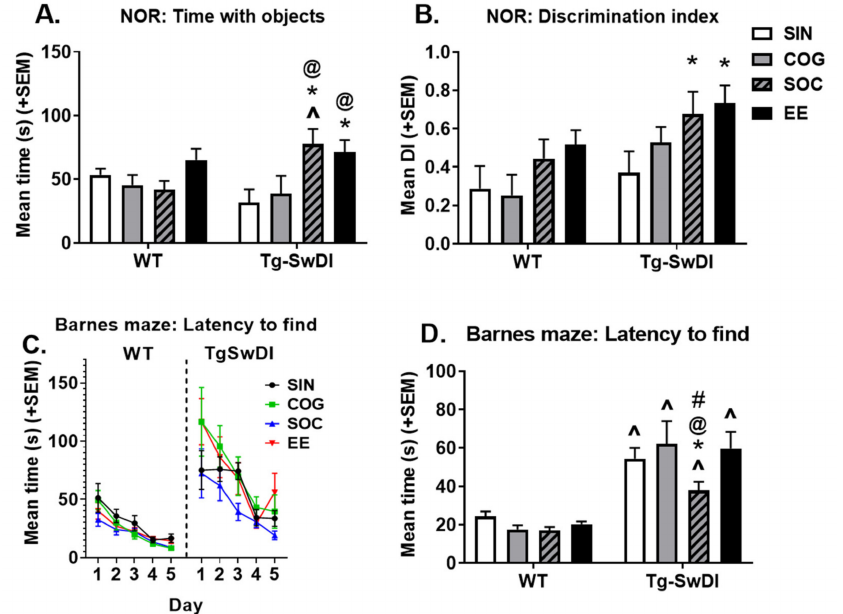
Figure 5. Cognitive testing. In Tg-SwDI mice, SOC and EE housing increased the amount of time spent with objects ( A ), and the discrimination index ( B ) in the novel object recognition (NOR) task. ( C ) Barnes maze performance, as measured by the latency to find the escape hole over time. ( D ) Barnes maze performance, as measured by the average latency to find the escape hole on days 2–5. Tg-SwDI mice took longer to find the escape hole compared to WT mice in all housing conditions. In Tg-SwDI mice, SOC housing was associated with improved performance (shorter latency to find the escape hole). * p < 0.05 vs. SIN of the same genotype, @ p < 0.05 vs. COG of the same genotype, % p < 0.05 vs. SOC of the same genotype, # p < 0.05 vs. EE of the same genotype, ˆ p < 0.05 vs. WT in the same housing